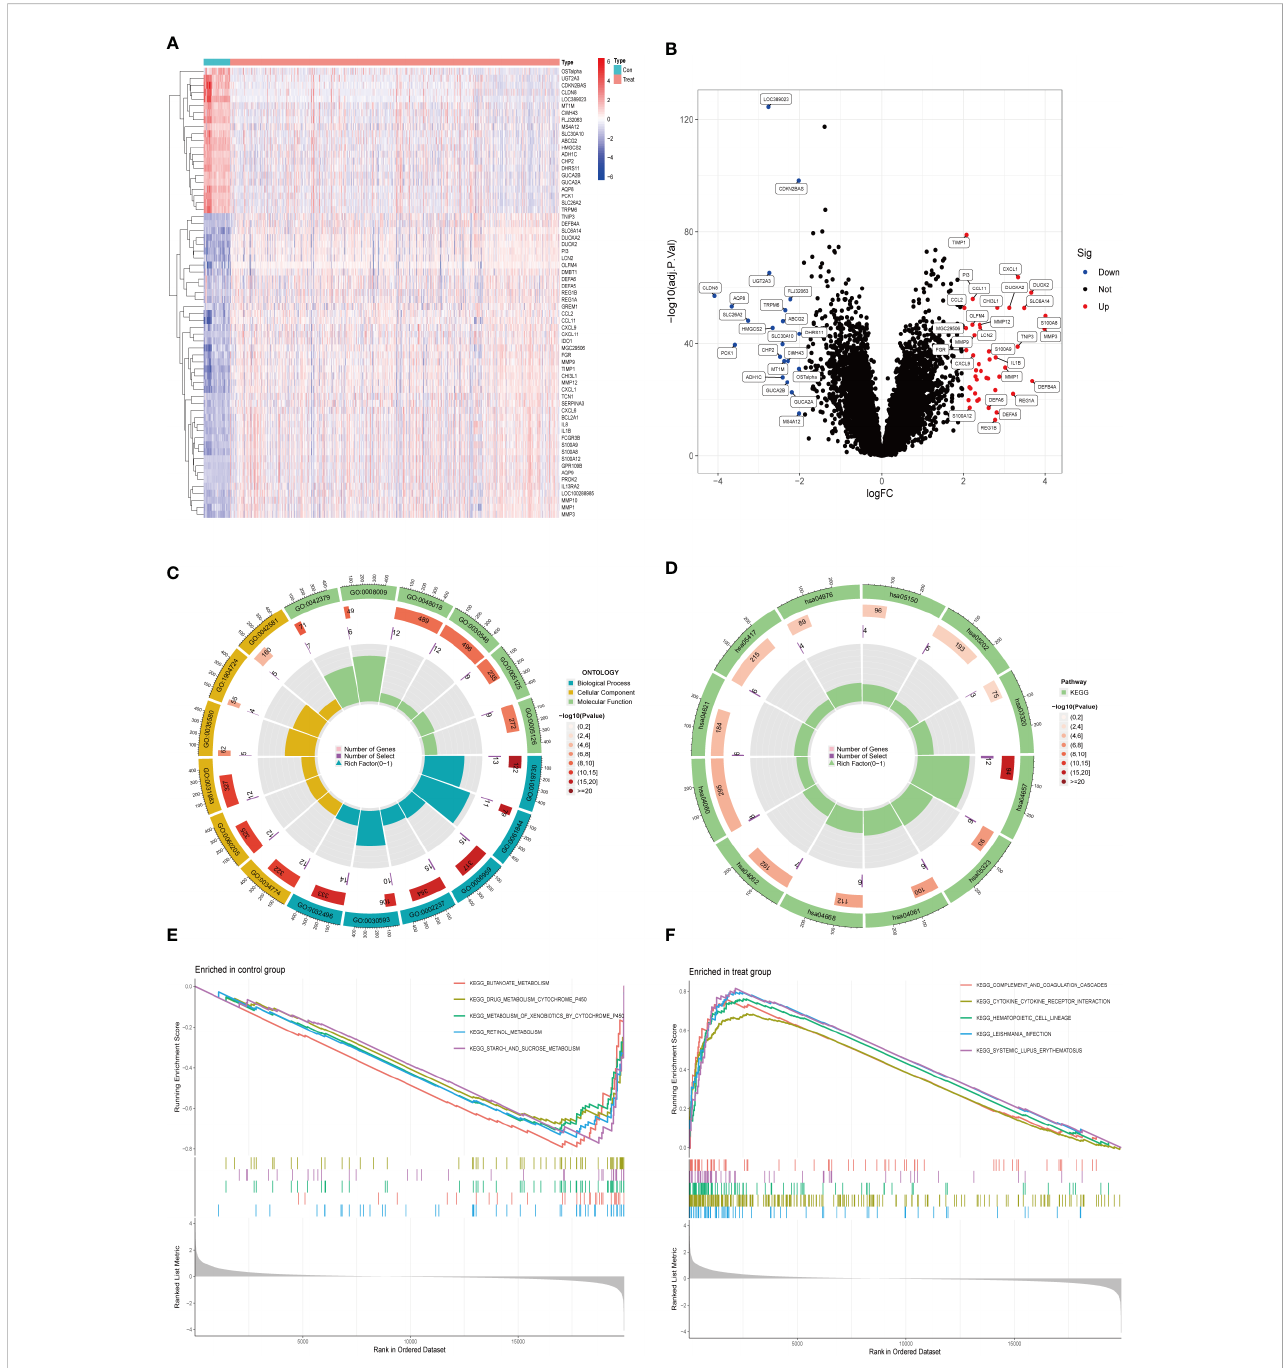
FIGURE 1 Identi fi cation of DEGs between UC and control samples. (A) The expression of 65 DEGs was visualized by heatmap. Red for upper regulation, blue for lower regulation (B) Volcano map of DEGs in UC compared to healthy controls. The signi fi cantly upregulated DEGs (log2FC>2, adj.P<0.05) were labeled in red, and the signi fi cantly downregulated DEGs (log2FC<2, adj.P<0.05) were labeled in blue. (C, D) GO and KEGG enrichment analyses of DEGs. The outermost circle was the GO number, the second circle represented the number of genes on the GO, and the third circle represents the number of genes enriched on the GO. The color represented the p-value of signi fi cant enrichment, the redder the color, the more signi fi cant the enrichment. (E, F) Results of GSEA pathway analysis in UC and healthy control